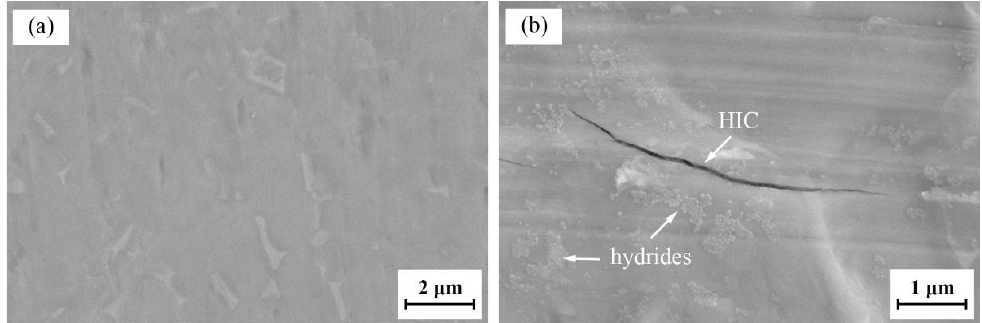
Figure 3. Surface morphologies of Ti6Al4V alloy before ( a ) and after ( b ) 1 h hydrogen charging in 3.5 wt.% NaCl solution.